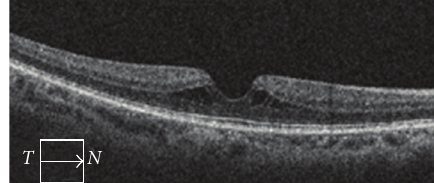
Figure 3: Optical coherence tomography of a lamellar macular hole with a smooth foveal contour. Notice intraretinal